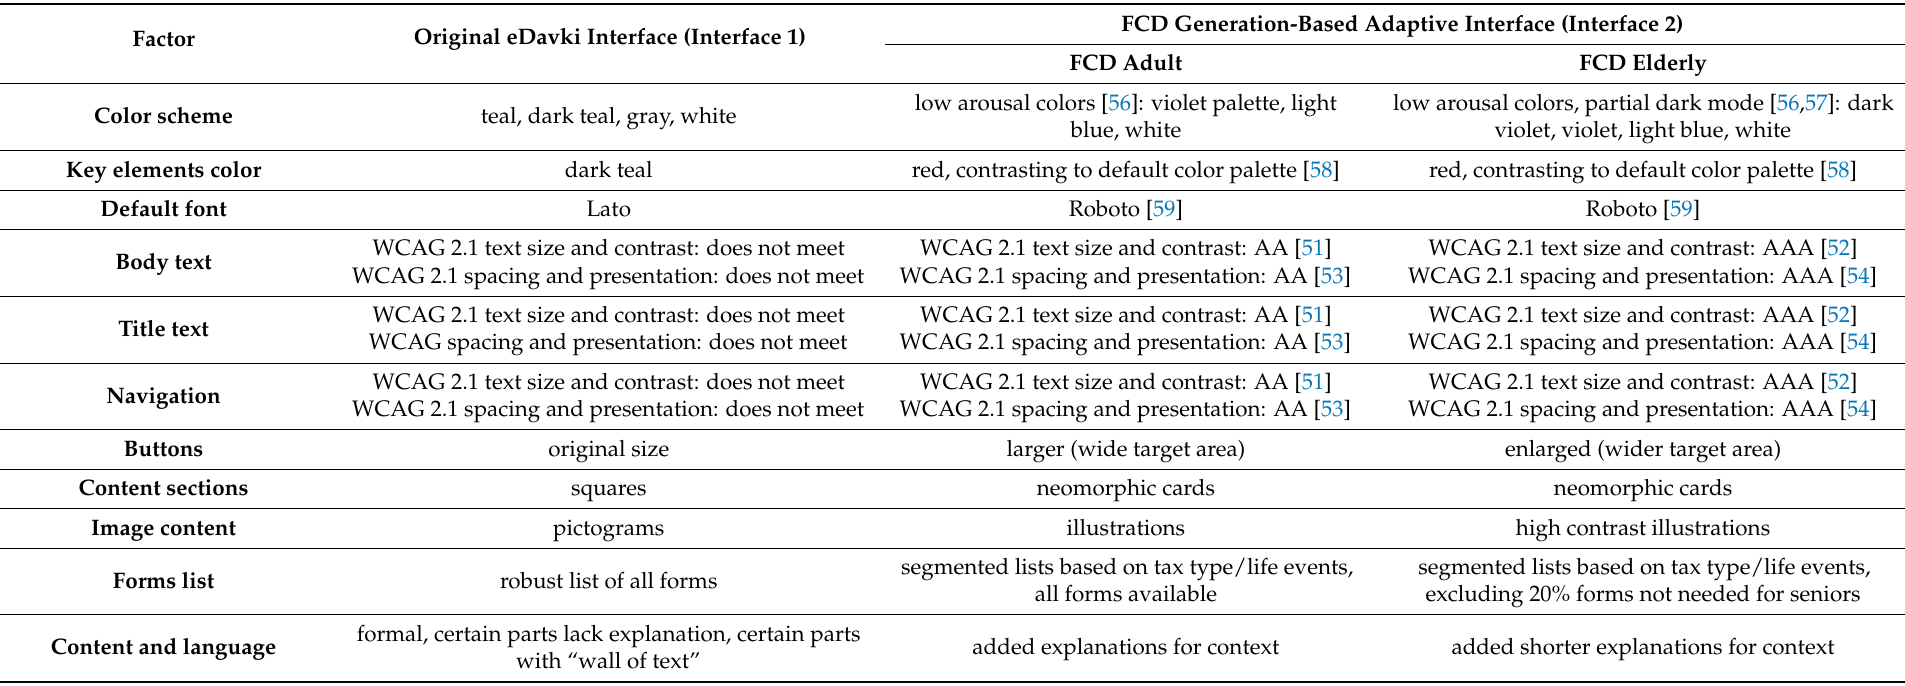
Table 1. Differences between the original, FCD adult and FCD elderly testing